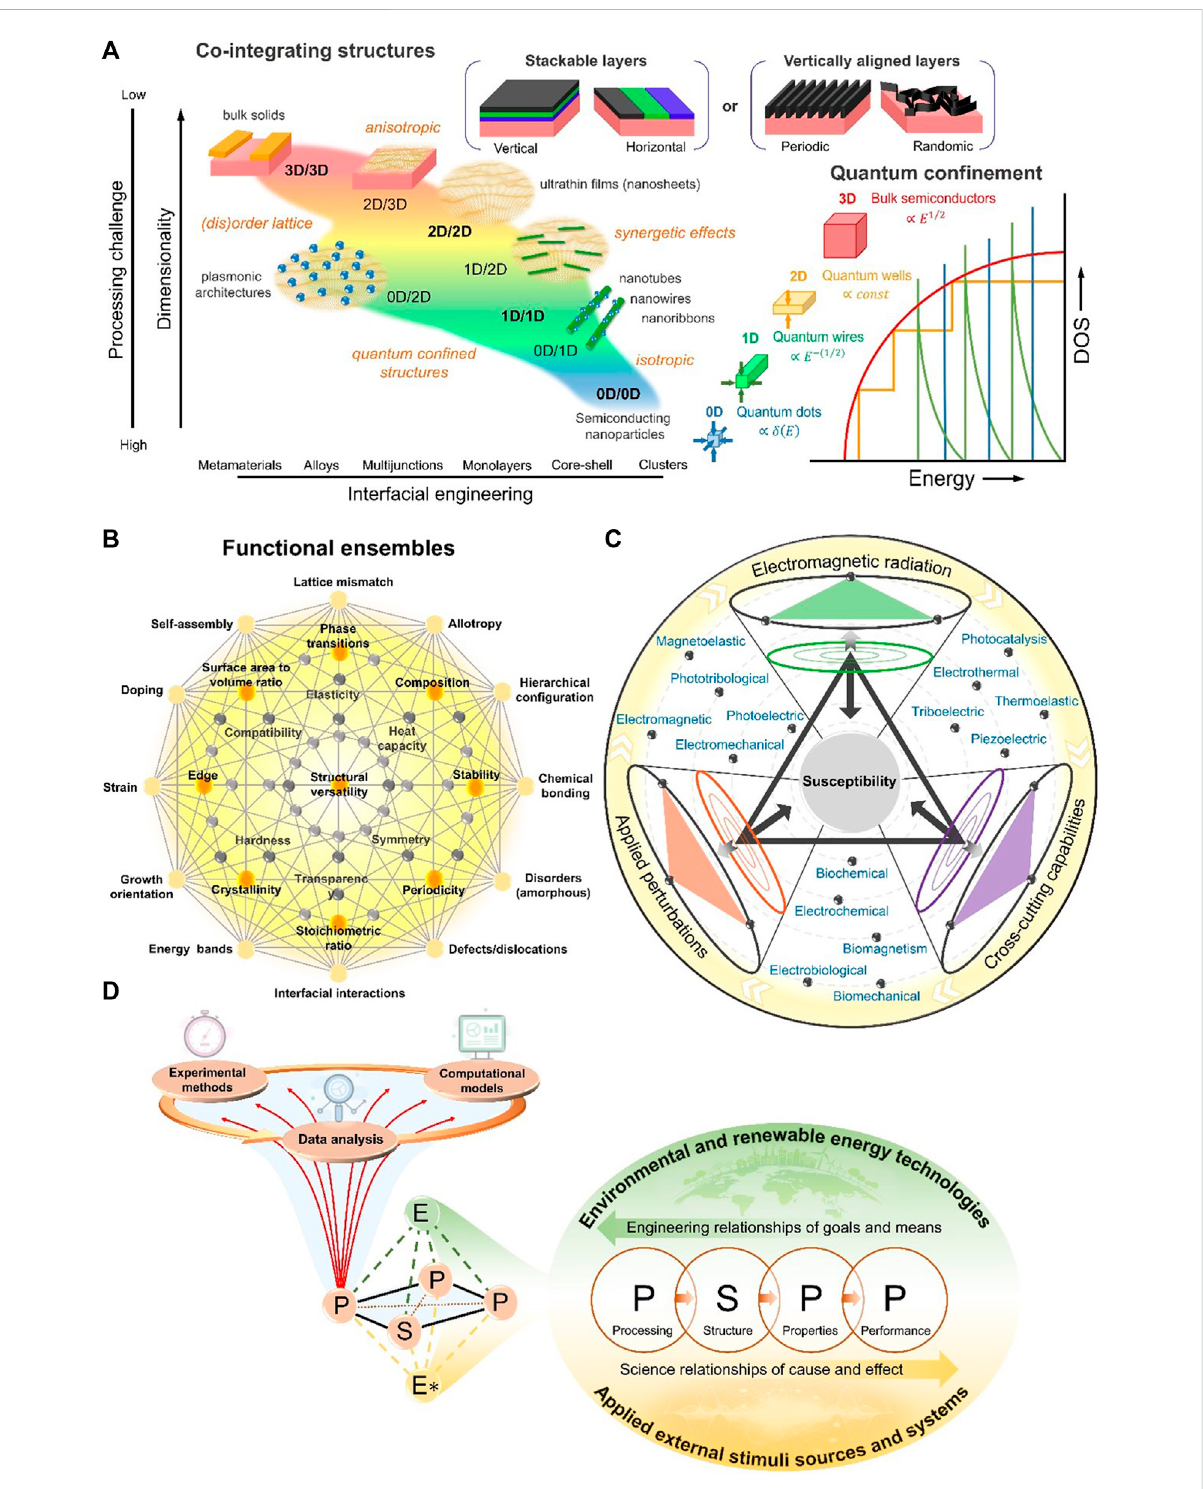
FIGURE 2 (A) Schematic overview of the proposed design guidelines on the co-integration structures (or combinatorial synthesis) in several dimensionalities and hybrid boundaries, originating from different types of interfacial engineering. Referring to quantum-con fi ned structures, the differencesindensityofstates(DOS)intermsofenergyappearwhenthesizeandshapeofnanocrystalsarereducedtolessthan100 nm.Itshouldbe noted that the spatial con fi nement of electron – hole pairs (excitons) occurs in one or more dimensions (de Broglie wavelength), resulting in more discrete electronic energy levels compared to the bulk materials with continuous behavior. Interrelationship diagrams of some intrinsic physicochemical characteristics kindred with function-driven engineering (B) and their susceptibilities (C) show the activity recognition by energy harvesting and storage derived from external sources and chemical/biological environments, which trigger a series of (non)systemic